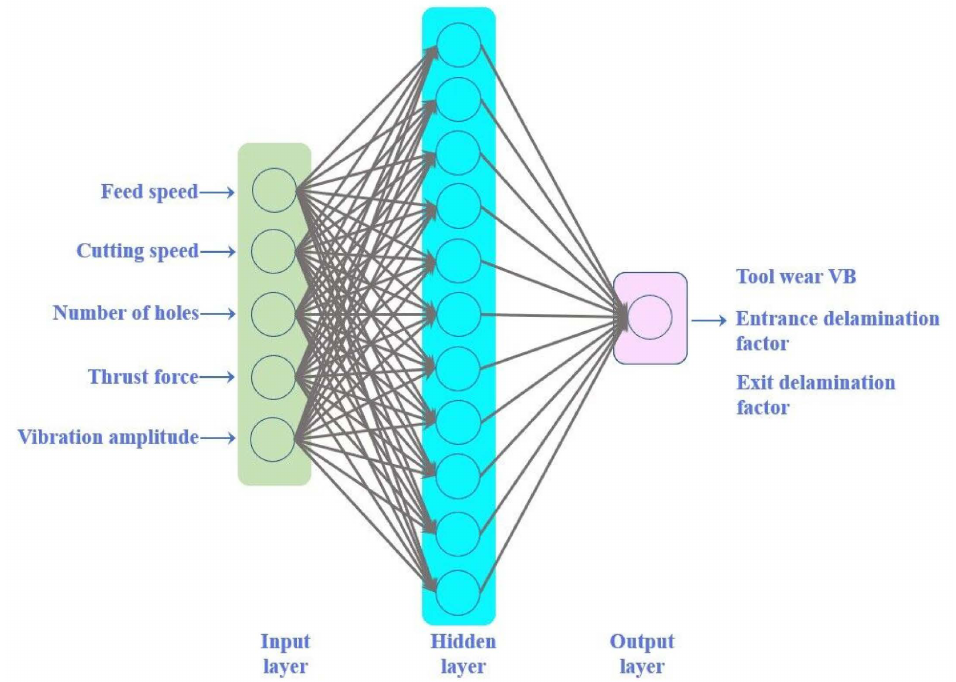
Figure 14. BP neural network prediction